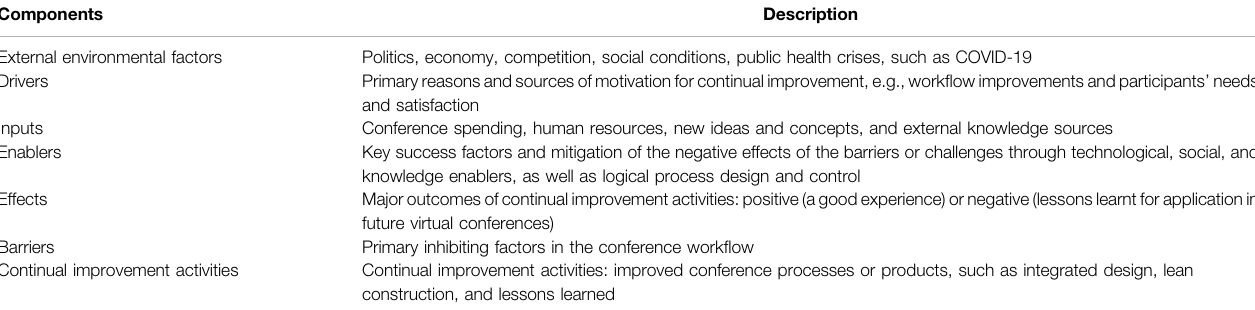
TABLE 4 | Components of a successful virtual international academic conference